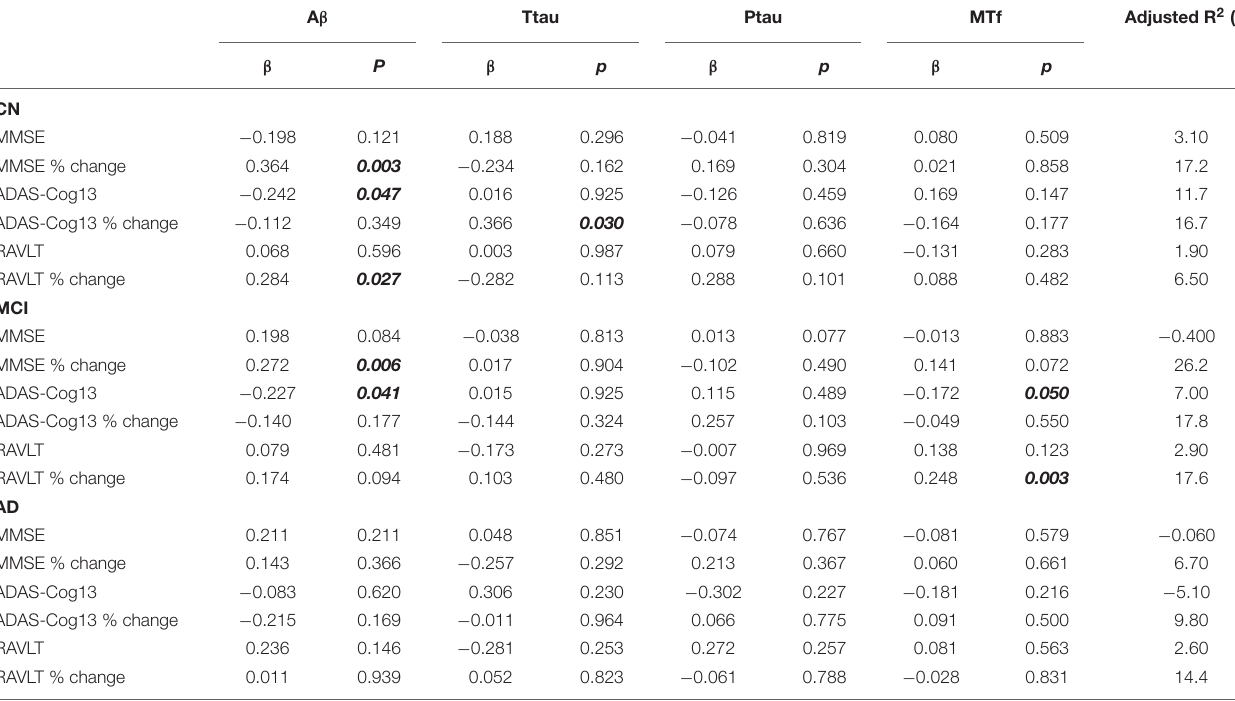
TABLE 5 | Association of CSF A β , total tau (ttau), phosphorylated tau (ptau), and melanotransferrin (MTf) with cognitive scores in cognitively normal (CN), mild-cognitive impairment (MCI), or Alzheimer’s disease (AD) ( Supplementary Figure 4 ). A